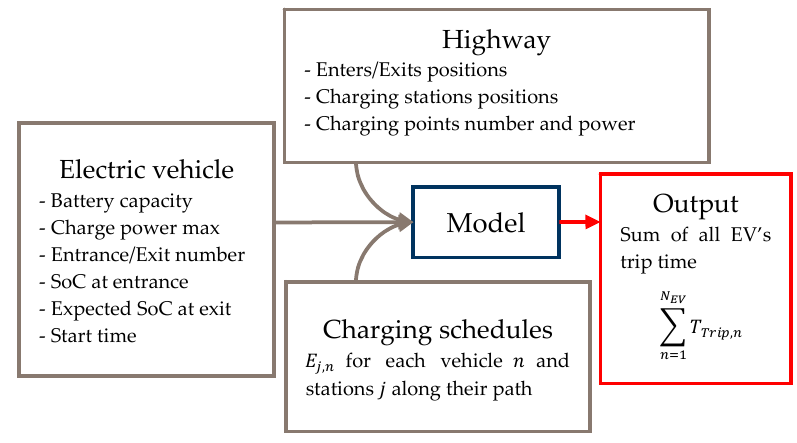
Figure 1. Structure of the simulation.